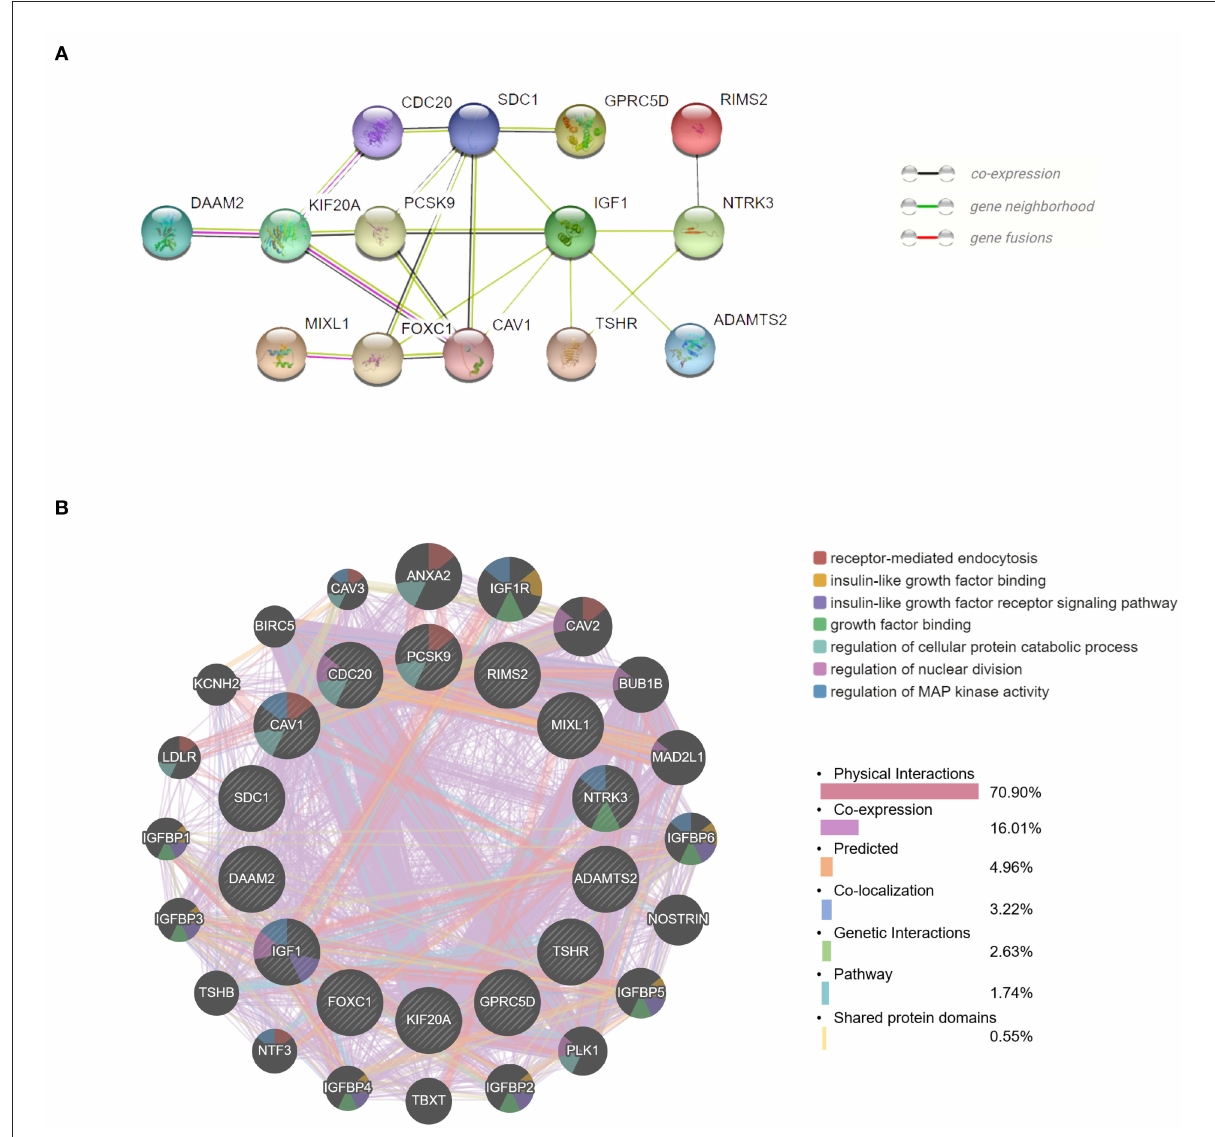
FIGURE5 Protein–protein interaction (PPI) network and function analyses of hub genes. (A) The PPI network of the top 14 hub genes created by STRING. (B) The PPI network and function analyses of 14 hub genes based on the GeneMANIA database. The inner circle presents the hub genes and the outer circle shows the potential genes interacting with hub genes. The circle size indicates the correlation with the input hub